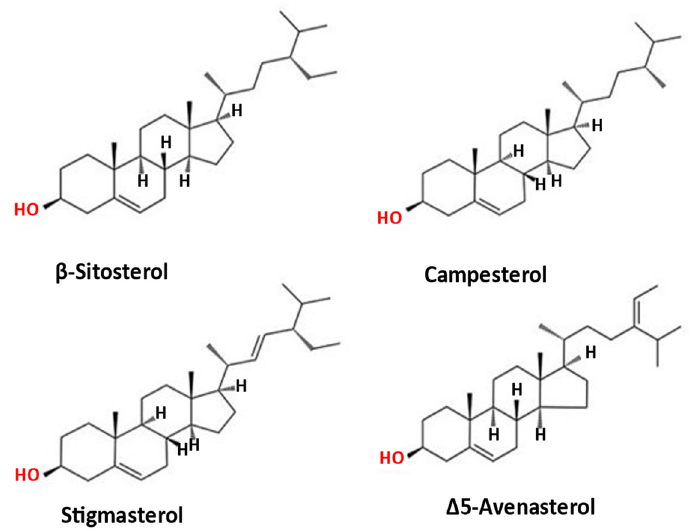
Figure 4. Chemical structures of the predominant phytosterols in cold-pressed macadamia nut oil.